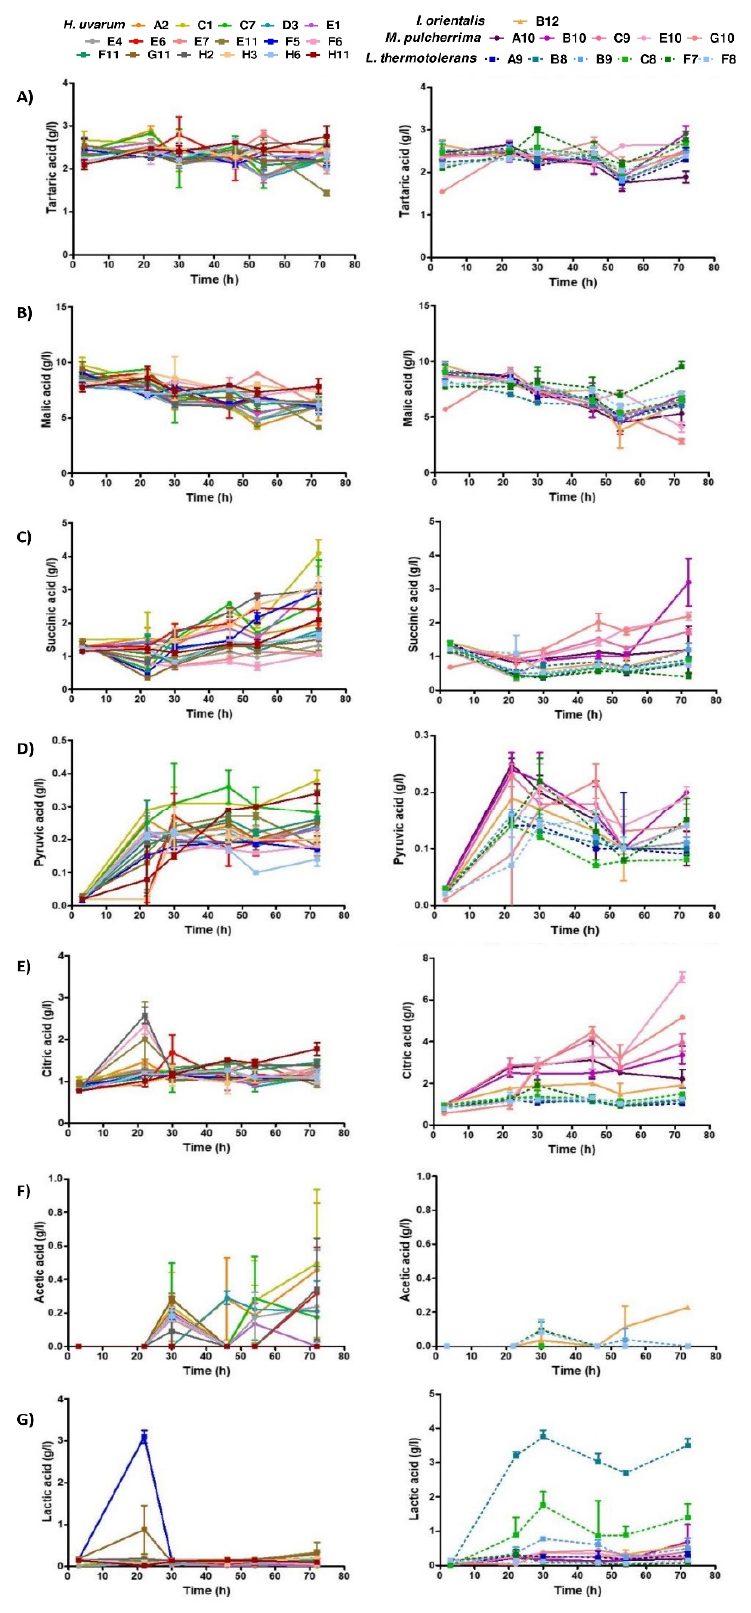
Figure 4. Quantification of organic acids for selected non- Saccharomyces species isolated from Port wine must samples. The concentration of tartaric ( A ), malic ( B ), succinic ( C ), pyruvic ( D ), citric ( E ), acetic ( F ), and lactic ( G ) acids for selected non- Saccharomyce s species isolated from Port wine must samples was quantified by HPLC. Results represent the mean value ± SD of triplicates, corresponding to three independent